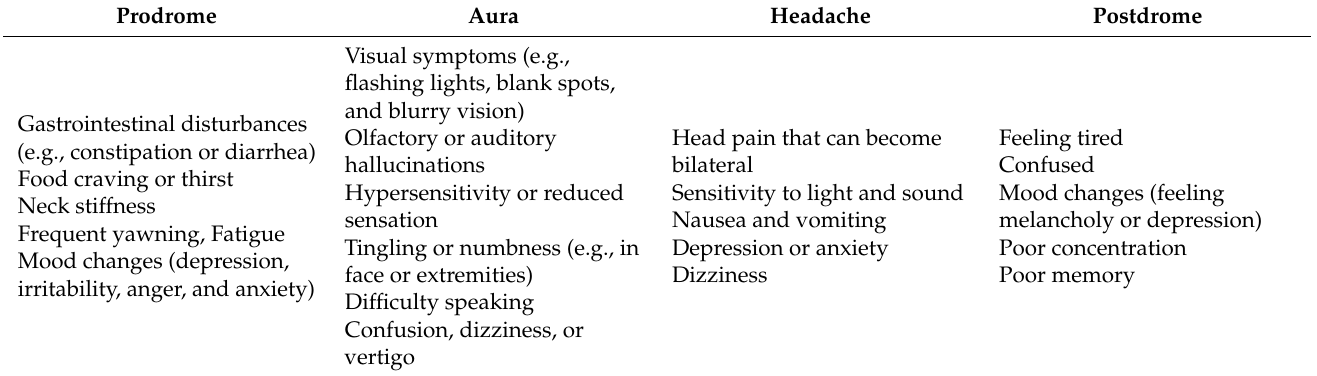
Table 1. Popular symptoms of four phases of a typical migraine